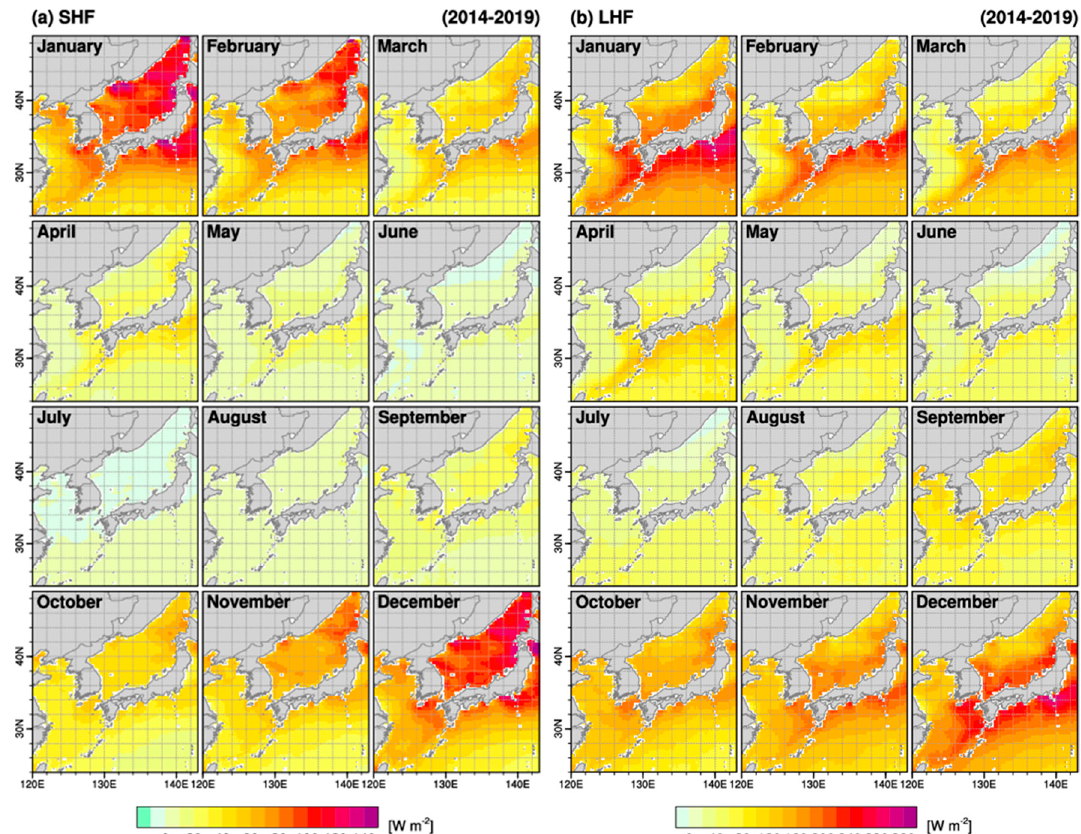
Figure 6. Monthly mean ( a ) SHF and ( b ) LHF during 2014–2019 around the Korean Peninsula. Monthly variations in air–sea variables and turbulent heat fluxes in the YS, ES, and ECS during the period 2014–2019 are shown in Figure 7 and Table 3. The SHF and LHF were low during the warm season and high in the cold season over the whole area (Figure 7g,h and Table 3). The SHF had little spatial variability during May–September, but the